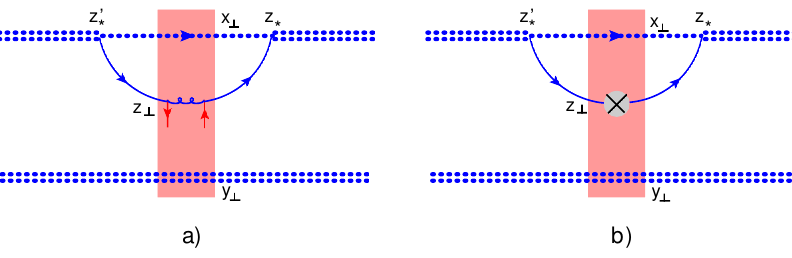
Figure 16 . Diagrams for the quark operators in the adjoint representation eqs. (6.44)–(6.47). Double dotted lines represent Wilson lines in the adjoint